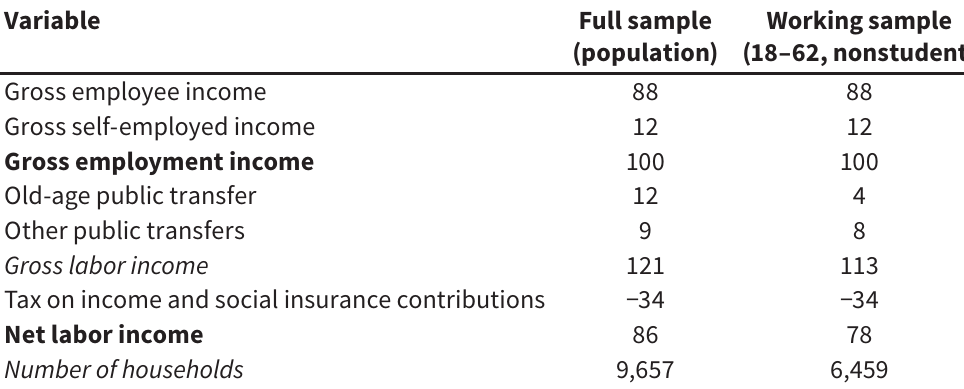
Detailed equivalized income and net tax in Lithuania, percentage of gross employment